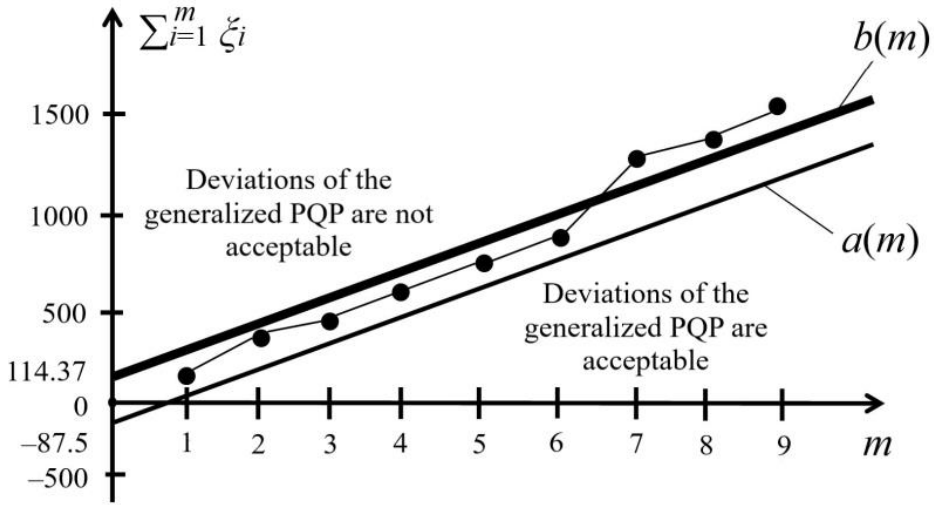
Figure 3. The process of sequential decision-making regarding the deviations of the generalized PQP. In the graph (Figure 3), points ( m ,